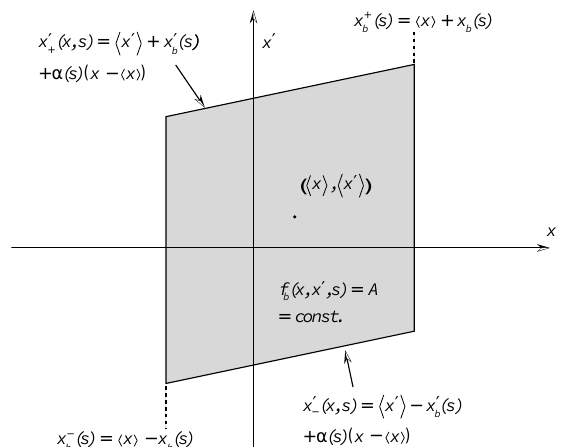
(cid:1) x , s (cid:2) (cid:1) (cid:7) x 0 (cid:8) 6 6